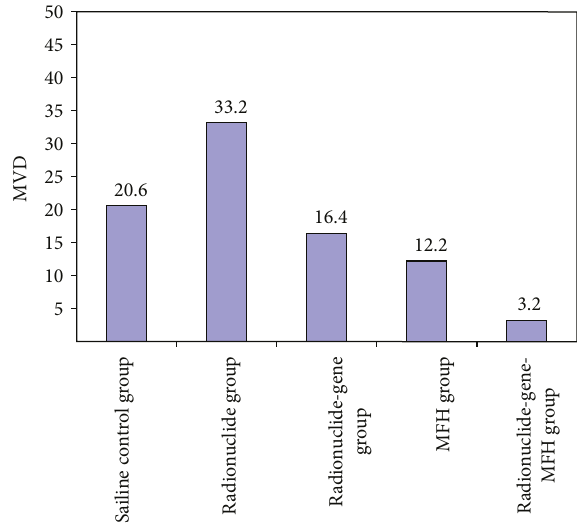
Figure 8: MVD in hepatoma tissues after di ff erent treatments.